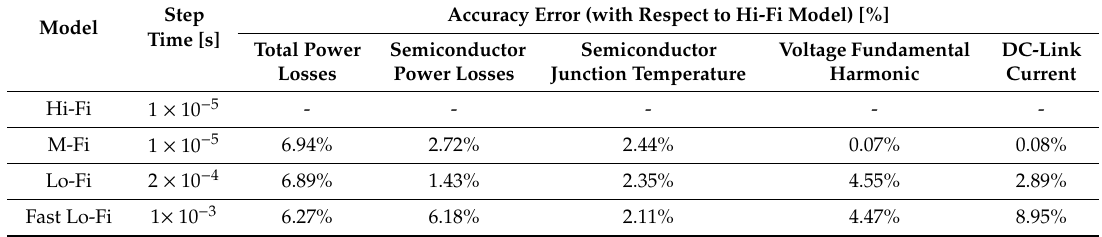
Table 6. Accuracy comparison between di ff erent inverter physical models for a braking scenario